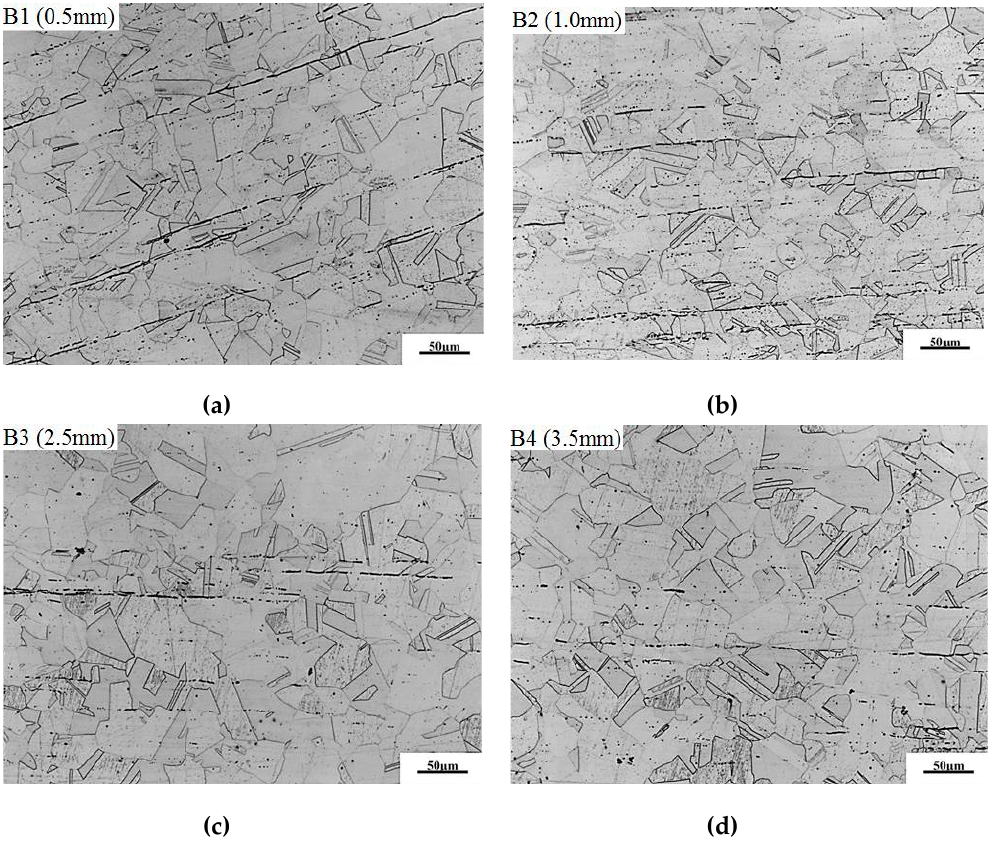
Figure 9. Effect of repair weld reinforcement height on the microstructure in the heat affected zone: Figure 9. E ff ect of repair weld reinforcement height on the microstructure in the heat a ff ected zone: ( a ) 0.5 mm, ( b ) 1.0 mm, ( c ) 2.5 mm and ( d ) 3.5